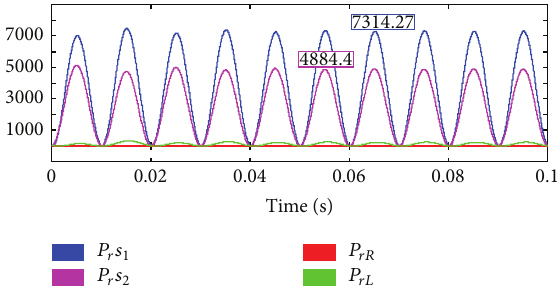
Figure 18: Reflected waves in the StBG of Figure